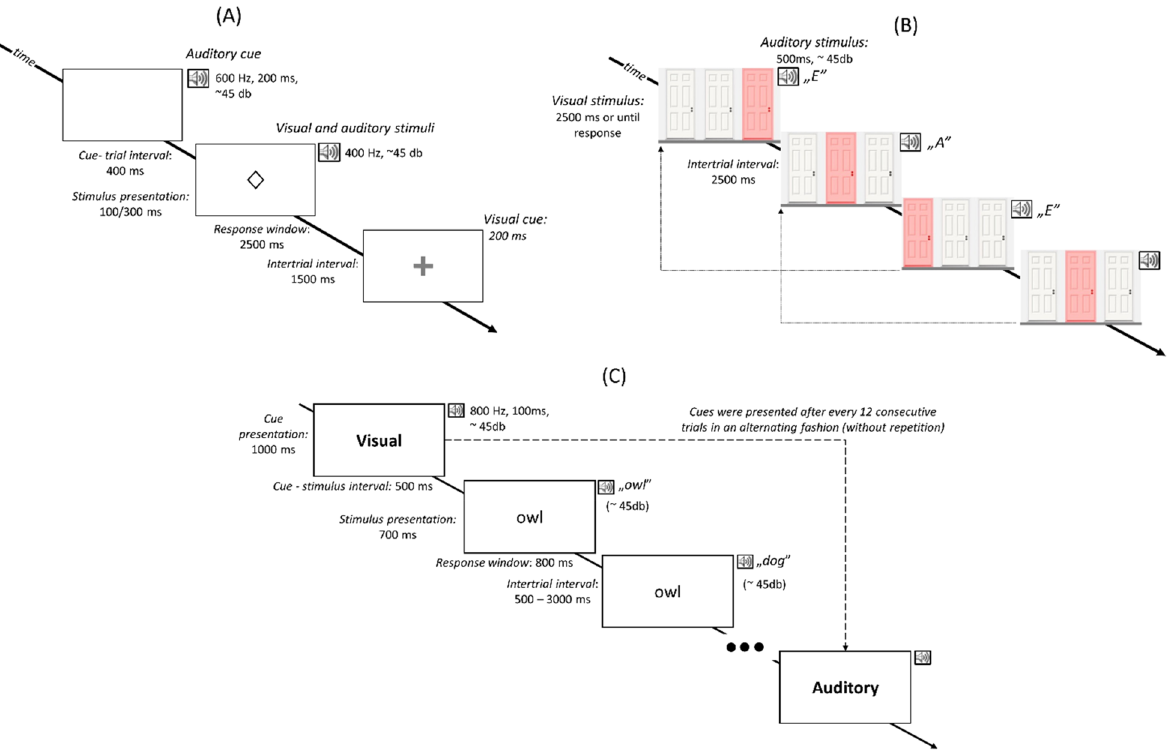
Figure 1. Schematised sequence of trials in the experiments. ( A ) In the task switching experiment, participants were required to decide the duration of the stimulus in the cued modality, while they had to ignore the stimulus presented in the other modality. ( B ) In the 2-back experiment, participants were asked to compare the auditory and visual stimuli in the actual trial to the stimuli presented two trials earlier and decide whether any of the two stimuli was identical to the one presented two trials earlier. ( C ) The Stroop experiment required participants to decide whether the word presented in the cued modality belonged to the semantic category of mammals or birds, while the word presented in the other modality had to be